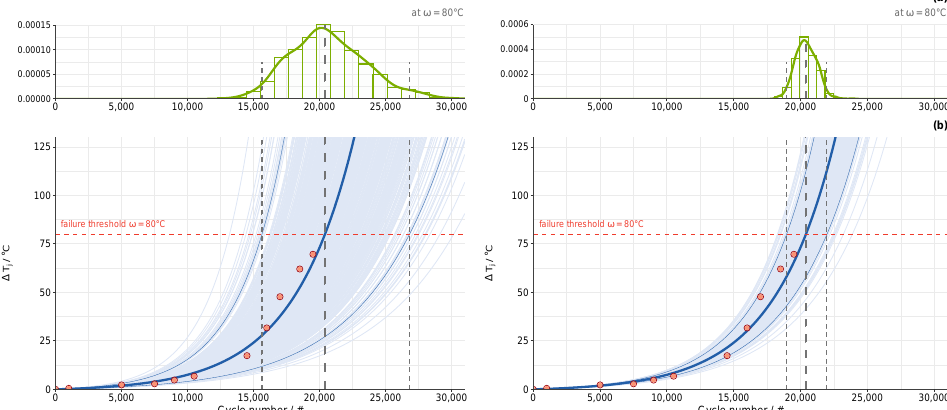
Figure 13. Impact of uncertainty in the initial temperature swing on RUL prediction in the presence of production and application variability: σ R pdf of failure based on failure threshold, ( b ) model predictions with 95% credible intervals based on the predictive uncertainty in ∆ T 0 from Section 5.1